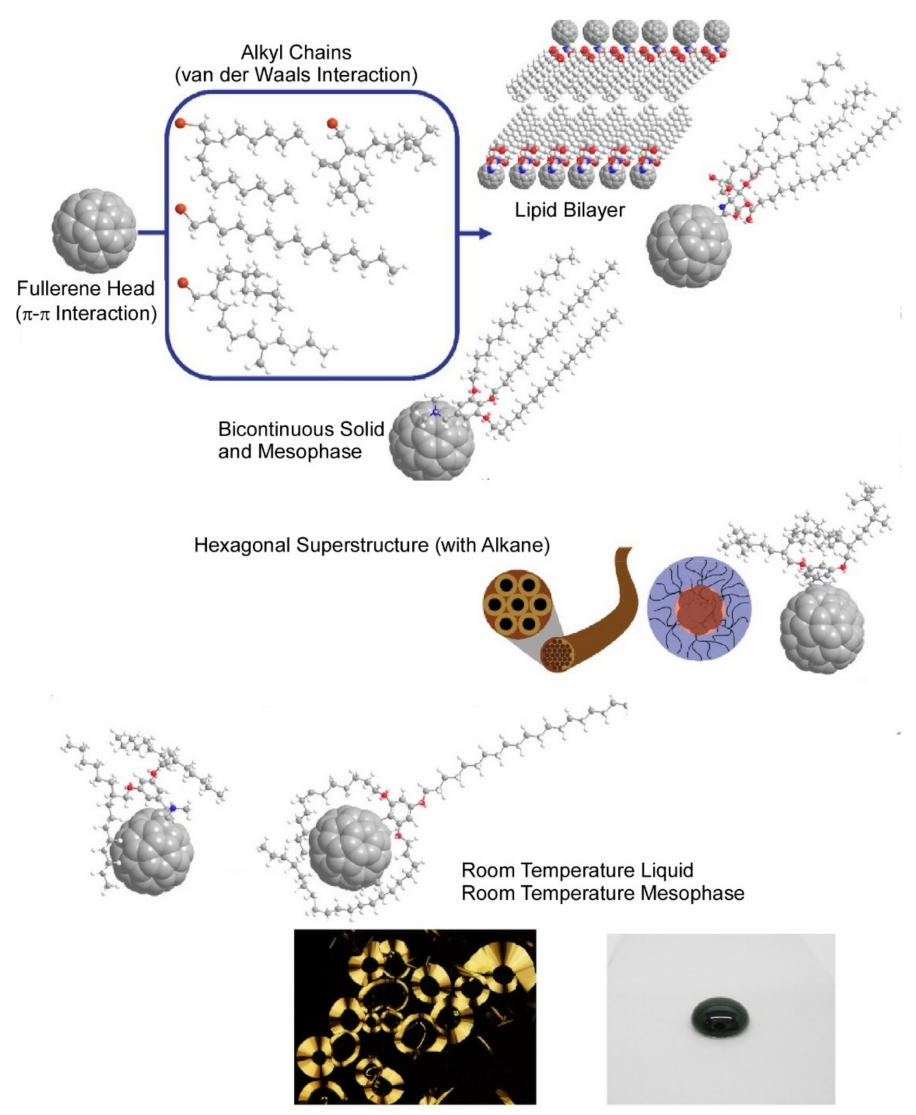
Figure 9. Diverse assembly structures formed by alkylated fullerenes. Reprinted with permission from [154]. Copyright 2021, Chemical Society of